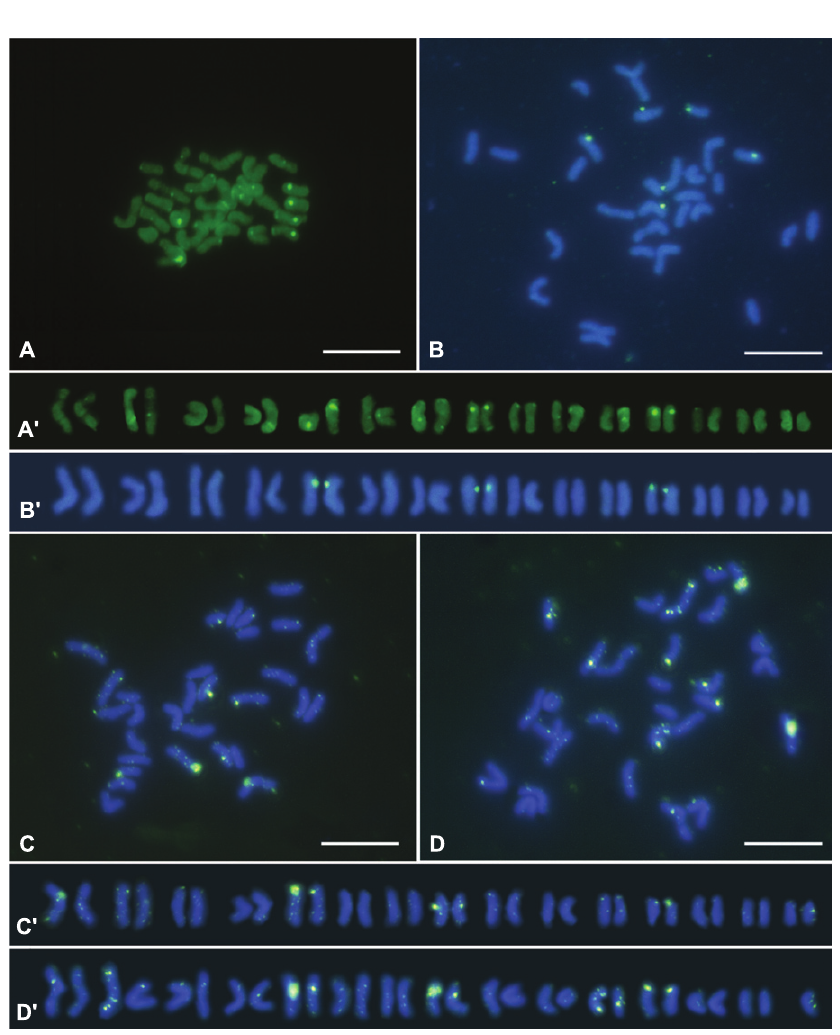
Fig. 5, A-D’. FISH in H. magnipapillata mitotic chromosomes with ks1 probes. Mitotic plates ( A , B ) and karyograms ( A’ , B’ ) from different FISH experiments with 1.5 kb size probe. Signals are visible in the same chro- mosome pairs: 5 th , 8 th and 12 th . Mitotic plate ( C , D ) and karyogram ( C’ , D’ ) after FISH experiment with 10 kb size BAC probe (clone 18A7) containing ks1 gene fragment. Bright signals are visible in the chromosome pairs 5 th , 8 th and 12 th . Additional weak signals are visible in some other chromosomes. Chromosomes are counterstained blue with DAPI. Bars = 10